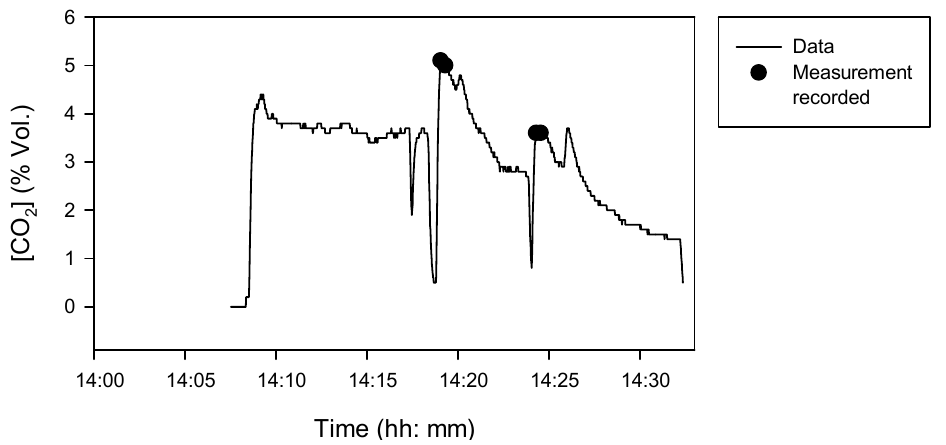
Figure A2. Example of the methodology followed for the measurements (example: [CO 2 ]).